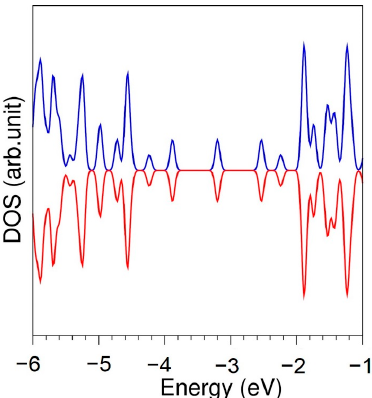
Figure 1. Density of states of graphene.